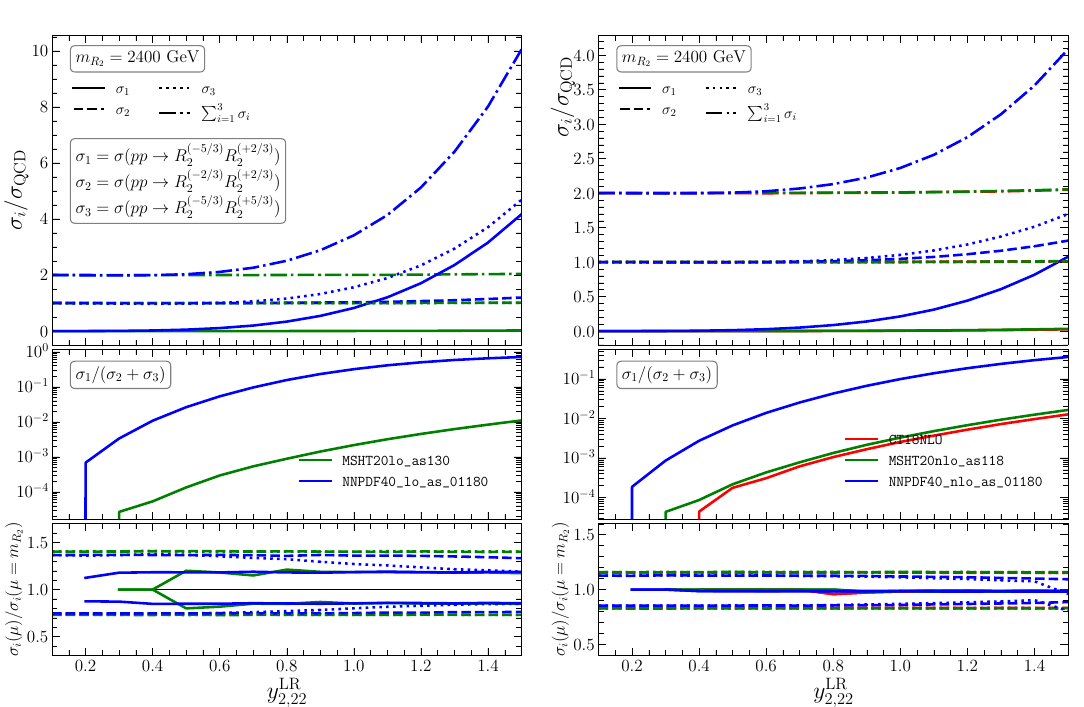
Figure 12 . Same as in figure 5 but for m R